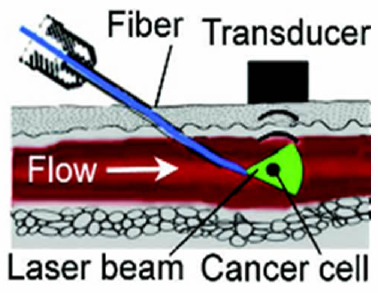
Figure 8. Minimally invasive fiber delivery of laser radiation into blood vessels with detection of acoustic waves by an ultrasound transducer on the skin